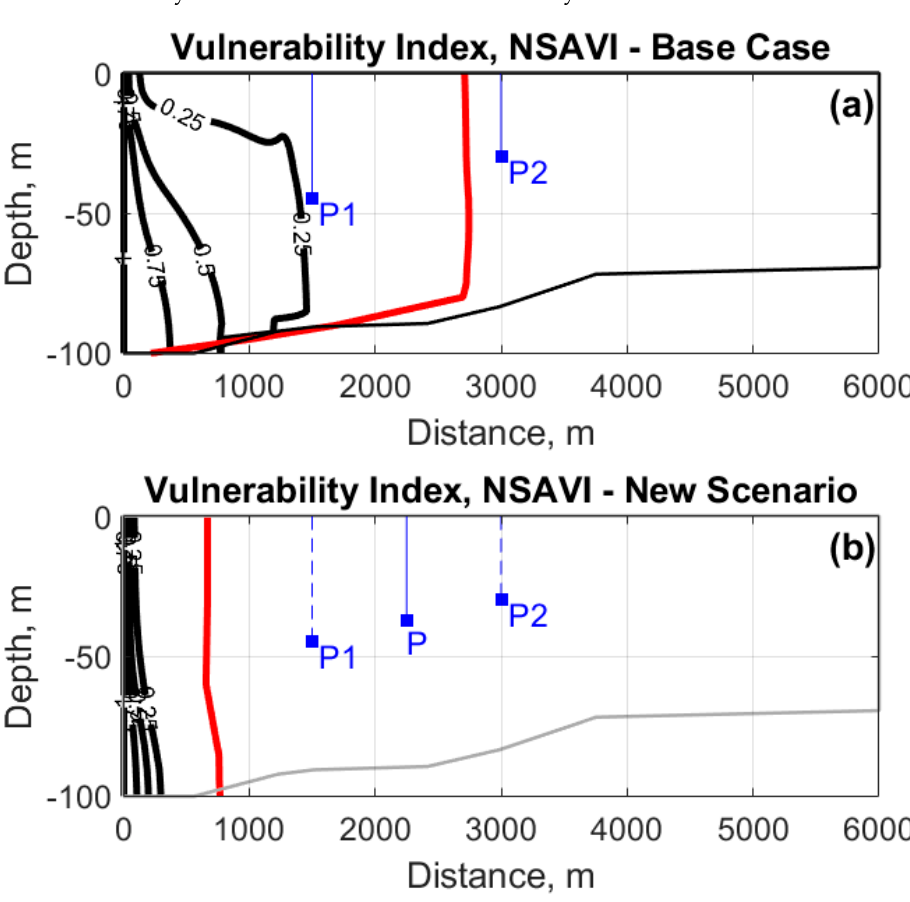
Figure 11. Spatial distribution patterns of the NSAVI vulnerability index and the zero-vulnerability line (ZVL) in the Akkar coastal aquifer (Lebanon) for ( a ) the actual conditions and ( b ) a newly proposed management scenario involving simultaneous relocation of the wells, decreasing the pumping density, and 20% decrease of the total flow rate.